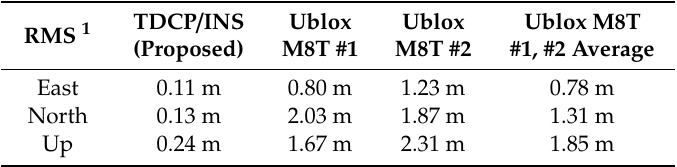
Table 1. RMS errors of the proposed method with other filtered solutions.